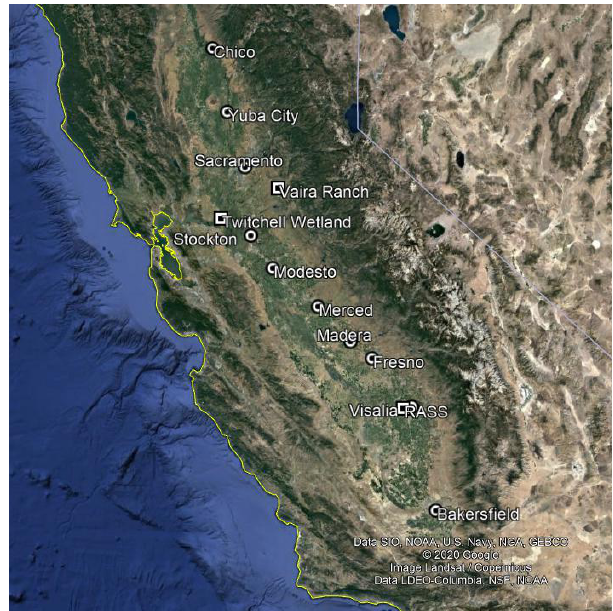
Figure 2. A map of the locations of CARB sites (circles), the RASS site, and AmeriFlux sites (squares) used in this study (© Google Earth